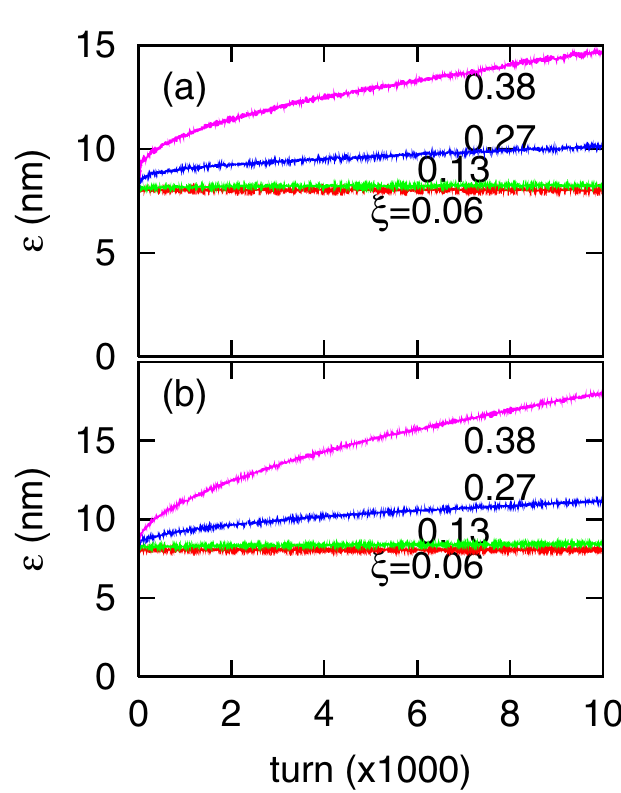
FIG. 10. (Color) Emittance growth for system with 3 degrees of freedom; transverse motion with equal tunes ( (cid:8) 0 : 2901 ) and synchrotron motion. Synchrotron tunes for plots (cid:5) 0 : 006 and 0 : 012 , (a) and (b) are (cid:8) s